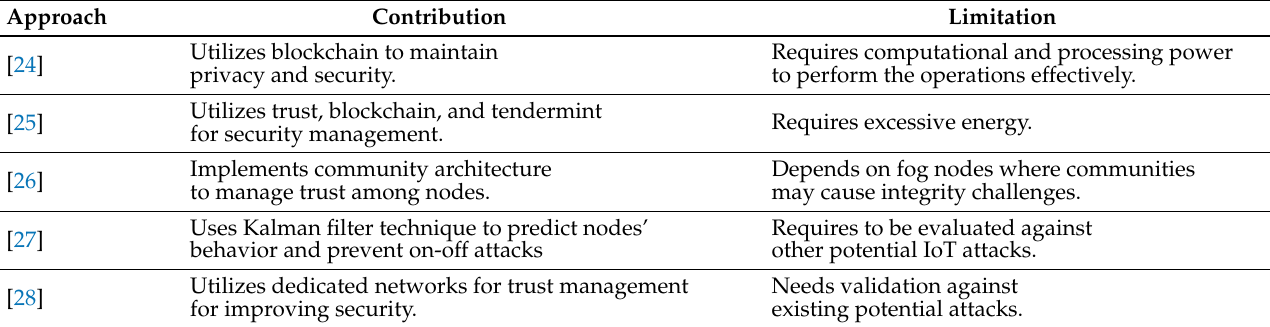
Table 1. Contributions and limitations of the existing approaches. Approach